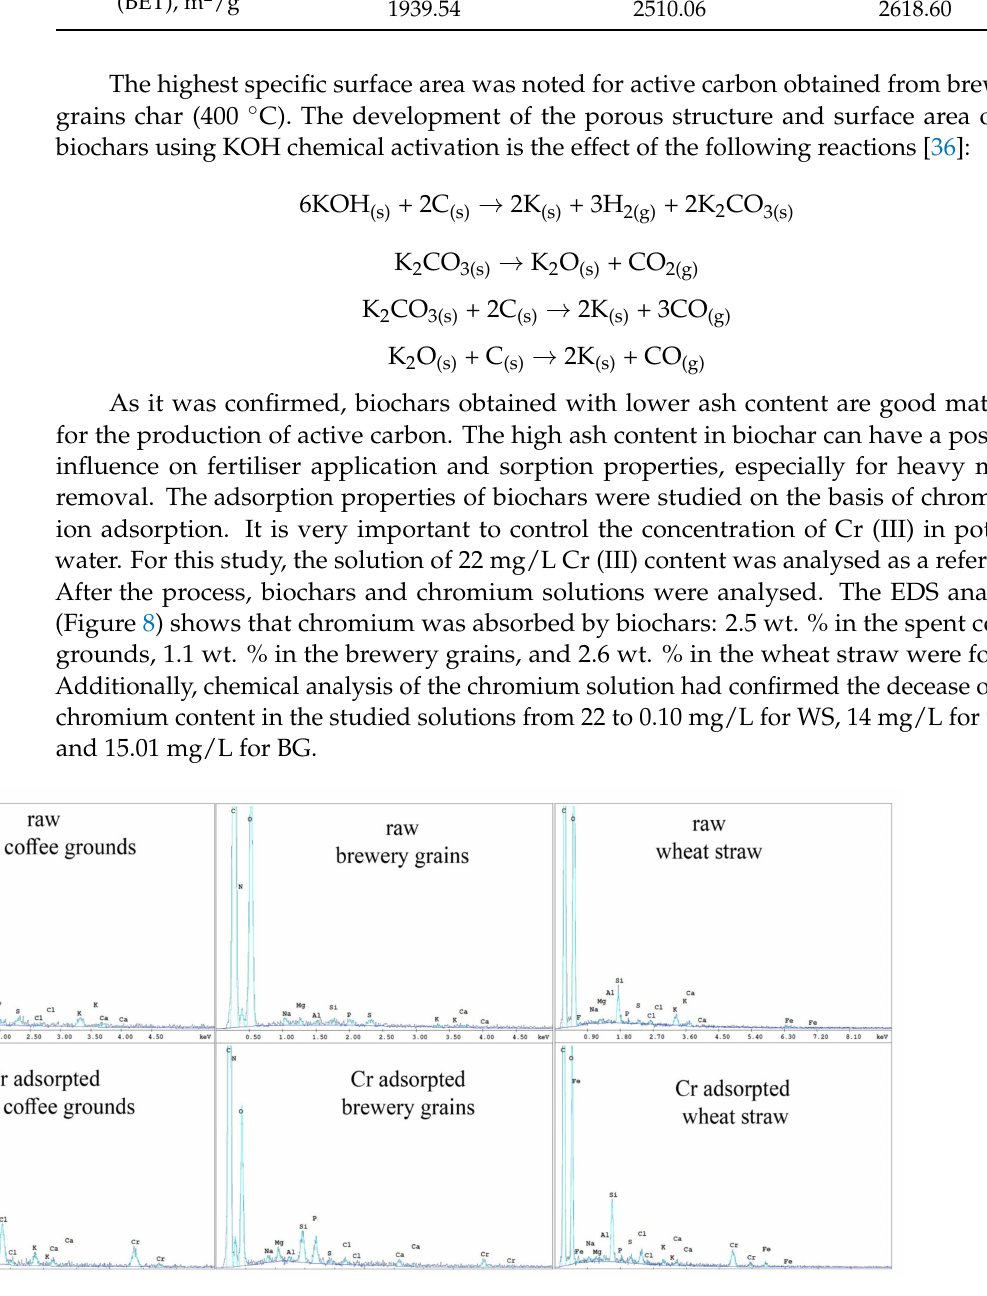
Table 4. Specific surface area (BET) biochars obtained at 400 ◦ C pyrolysis after activation process. Specific surface area